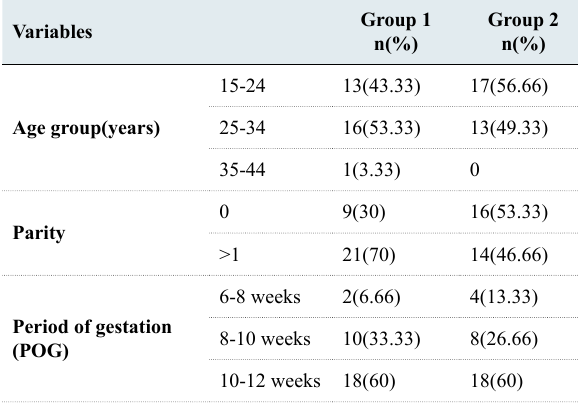
Table 1: Distribution of patient according to age, parity,